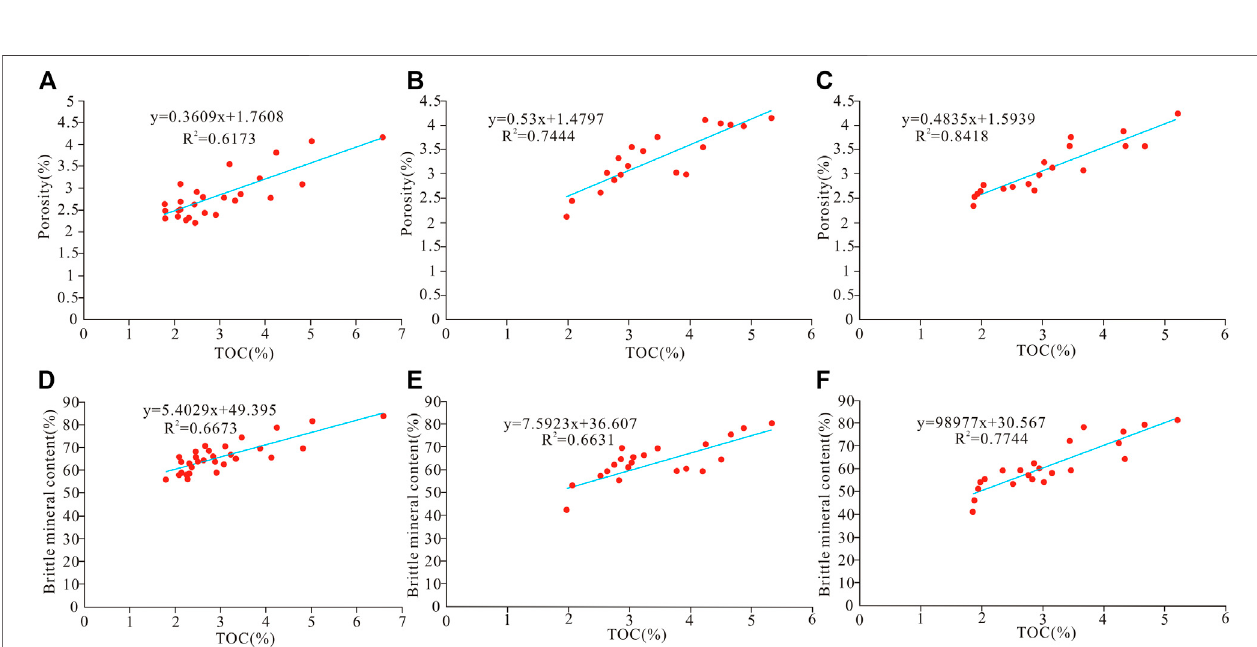
FIGURE10| Relationshipamongshaleorganicmattercontent,shaleporosity,andbrittlenessinsouthernSichuan. (A – C) representtherelationshipcurvebetween TOC content and porosity repectively in Luzhou area, Changning area and Weiyuan area. (D – F) correspond to the relationship curve between TOC content and brittle mineral content respectively in Luzhou area, Changning area and Weiyuan area.